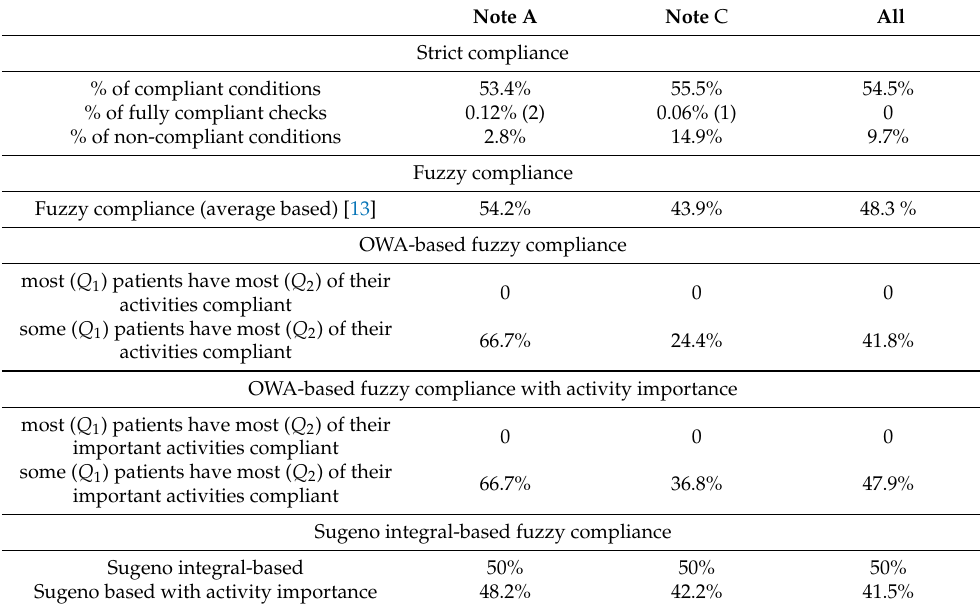
Table 6. Compliance values for different compliance